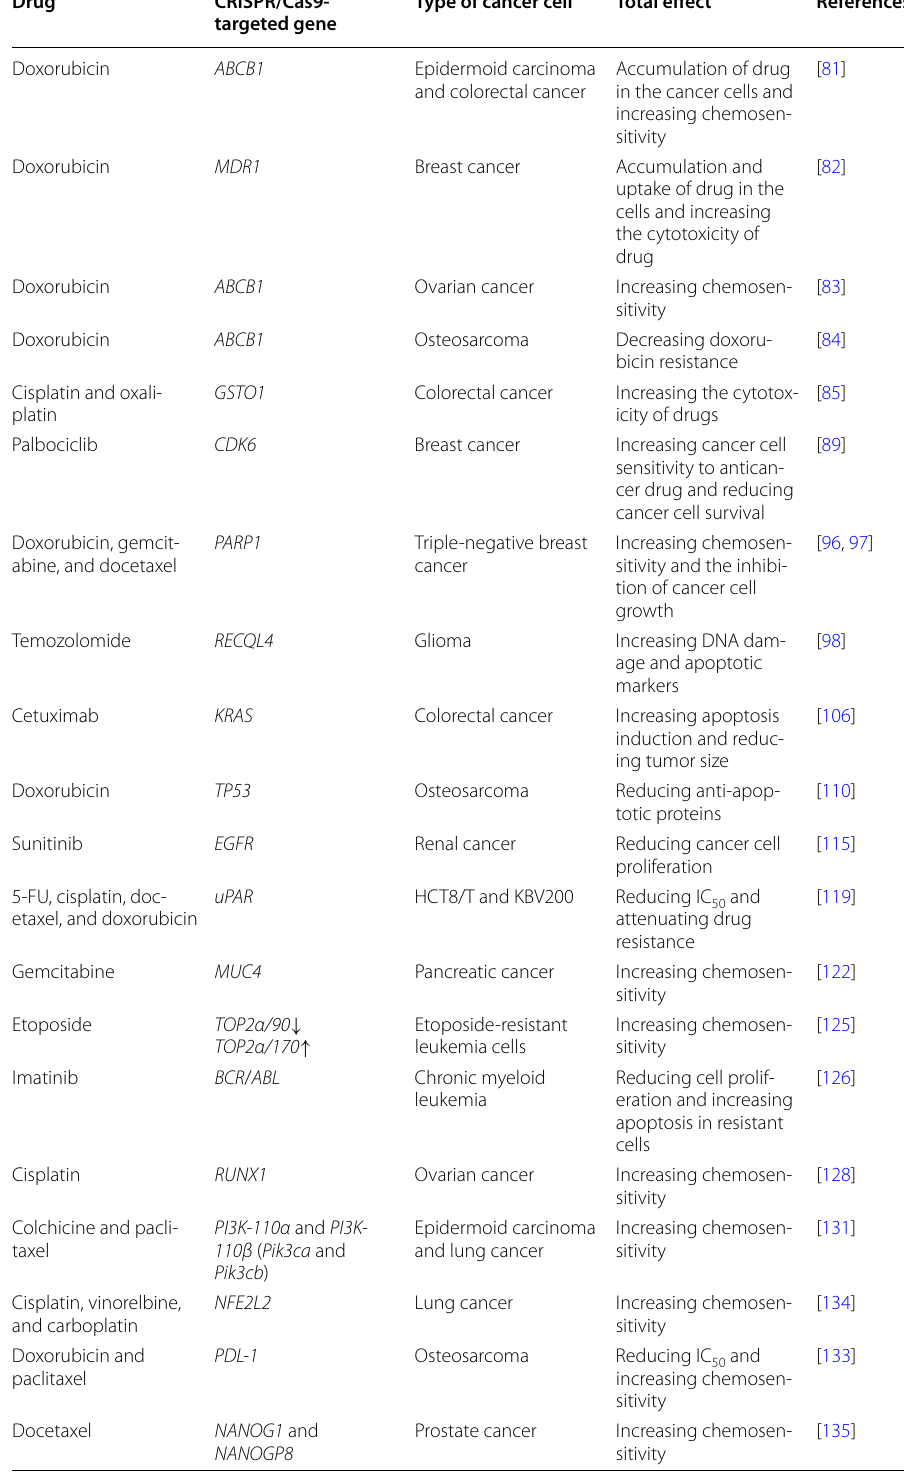
Table 1 The target genes and effectiveness of CRISPR/Cas9 technology in overcoming drug